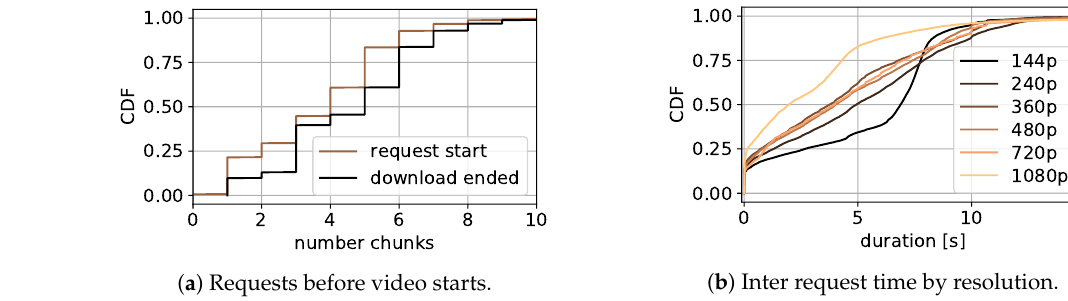
Figure 5. Dataset study: initial delay and video